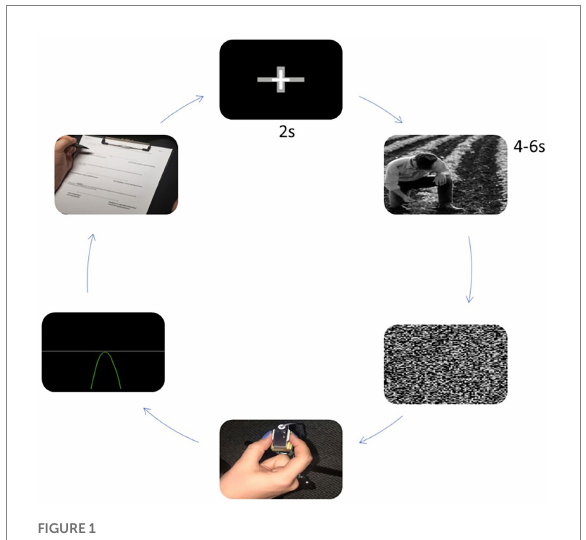
FIGURE 1 Set-up of experimental